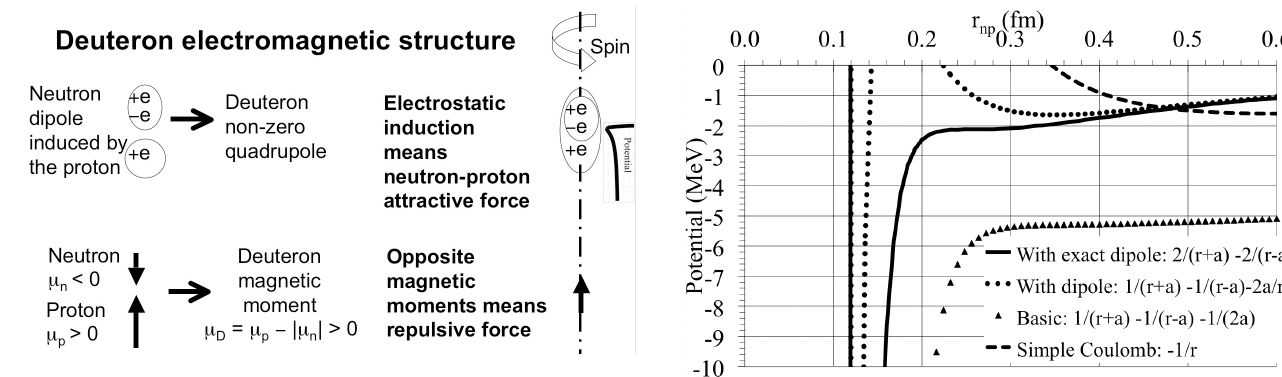
Figure 1: Schematic deuteron structure. - The elementary charges are assumed to be punctual. The proton contains an elementary charge + e . The neutron contains electric charges with no net charge, assumed to be + e and − e . The electric charges of the neutron are separated by 2 a by the electric field of the proton distant by r np . The proton at- tracts electrically the neutron as a rubbed plastic pen attracts small pieces of paper. The magnetic moments of the proton and the neutron are opposite. They are also collinear in the deuteron by reason of symmetry. Their magnetic interac- tion equilibrates the electrostatic attraction.